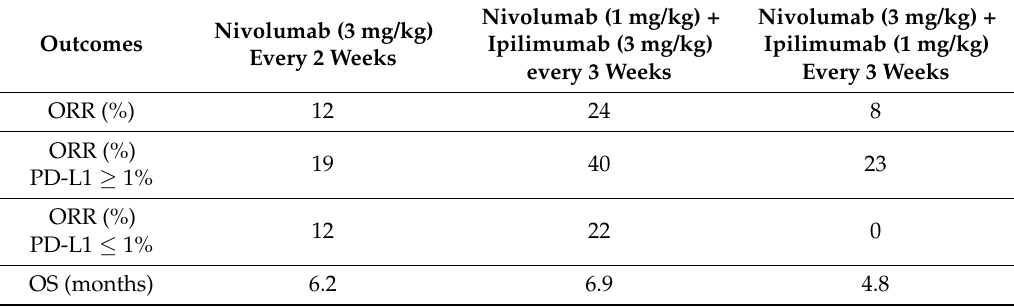
Table 4. Results of a phase II clinical study to investigate nivolumab and ipilimumab in metastatic gastric or gastroesophageal junction